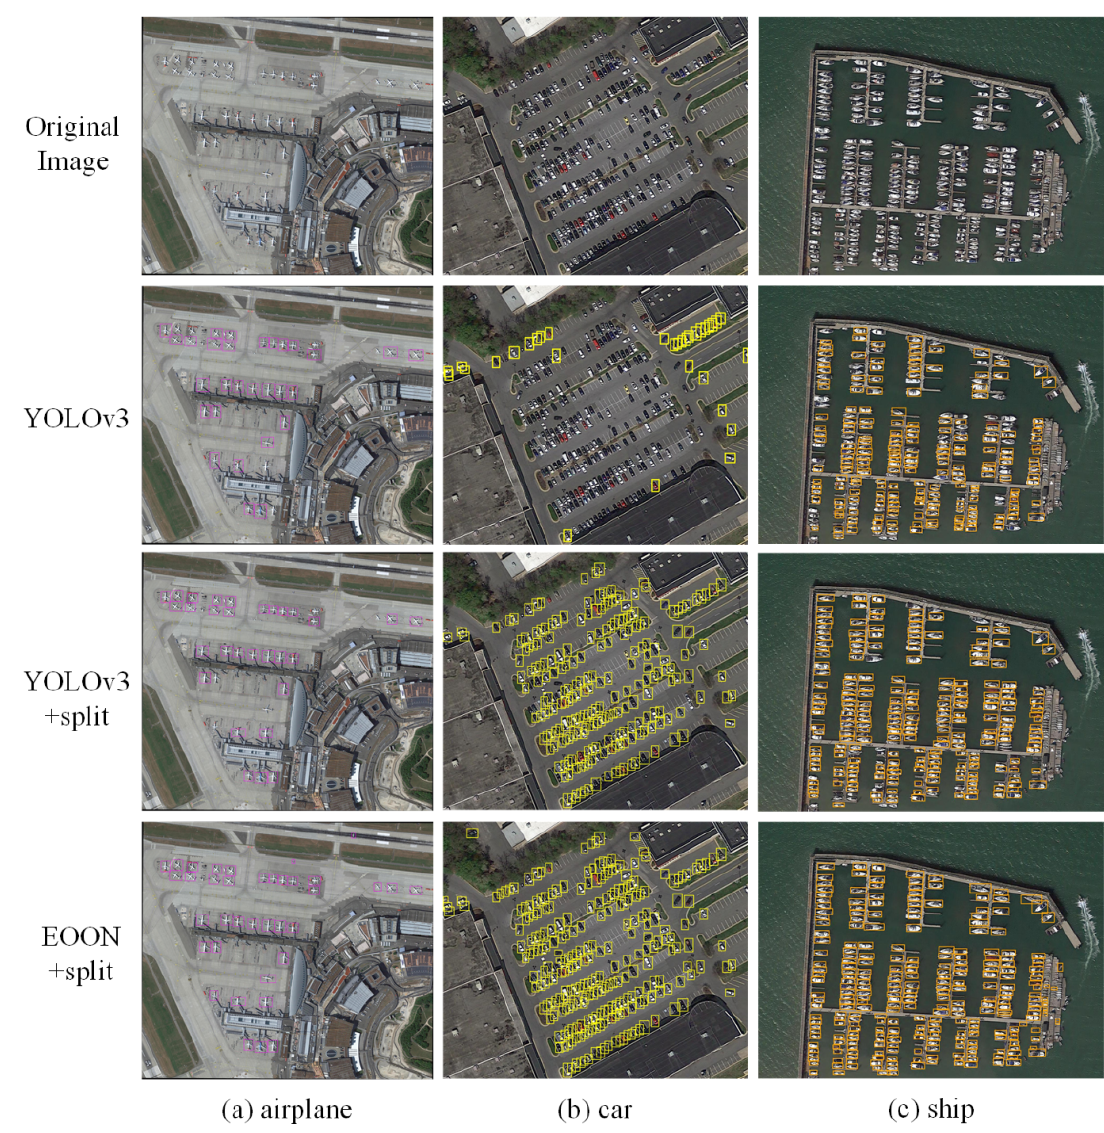
Figure 10. Some detection results with three categories (( a ) airplane; ( b ) car; ( c ) ship) to validate the performance of NEOON as well as the split and merge strategy. The first row shows the original images to be detected. The second row demonstrates the results obtained by YOLOv3. The third row shows the results obtained by YOLOv3 with the split and merge strategy. The last row is the detection results by NEOON with the split and merge strategy. In ( a ), YOLOv3 gets similar results as YOLOv3+split; however, YOLOv3+split achieves a higher classification confidence score than YOLOv3. Note that the first two methods cannot detect the tiny objects such as the two airplanes at the top of the testing image. However, the proposed NEOON can make it and detect more objects; in ( b ), cars are harder to detect than airplanes because they occupy fewer pixels and YOLOv3 can detect only a few cars. With split and merge strategy, both YOLOv3 and NEOON have shown a great detection performance especially for NEOON which is better at detecting indistinguishable small objects; in ( c ), the same as the cases in ( a , b ), the proposed NEOON has achieved the best results in ship